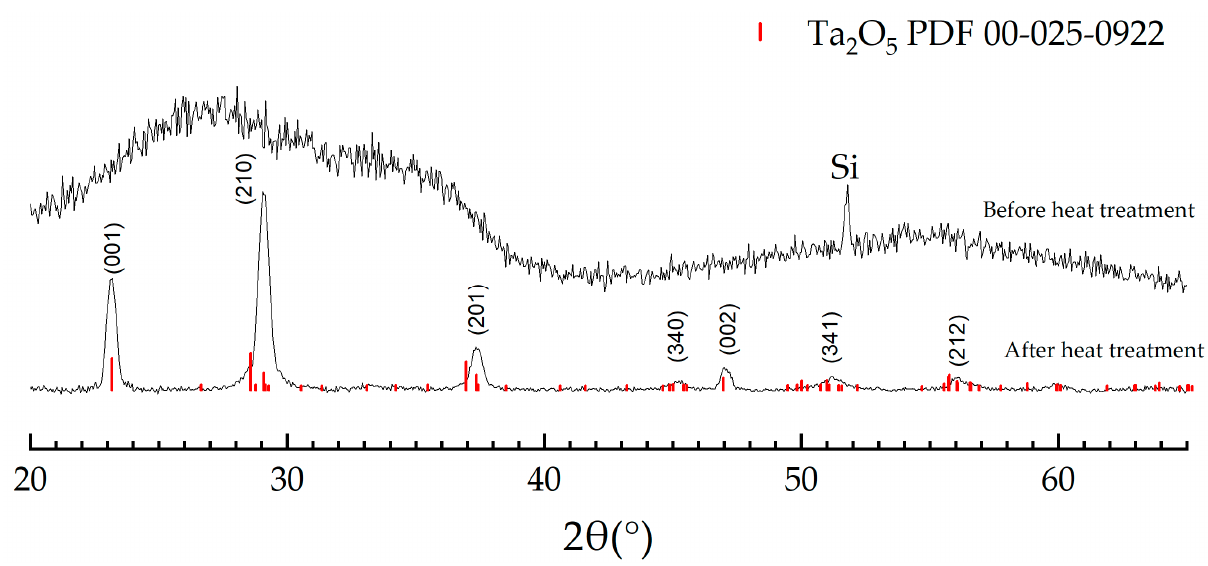
Figure 5. XRD of Ta-O films before and after HT.